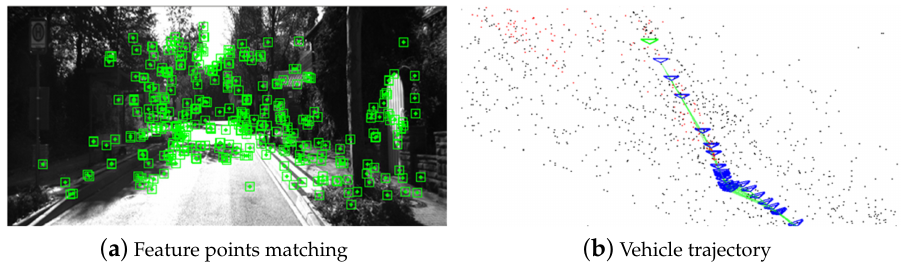
Figure 15. 3DDA-GAN applied in ORB-SLAM2.